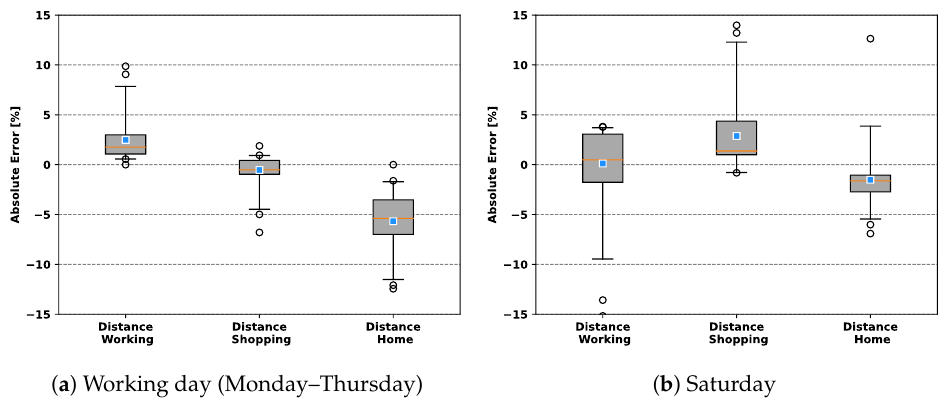
Figure 8. Modelling error distance distributions. The blue square depicts the mean error.